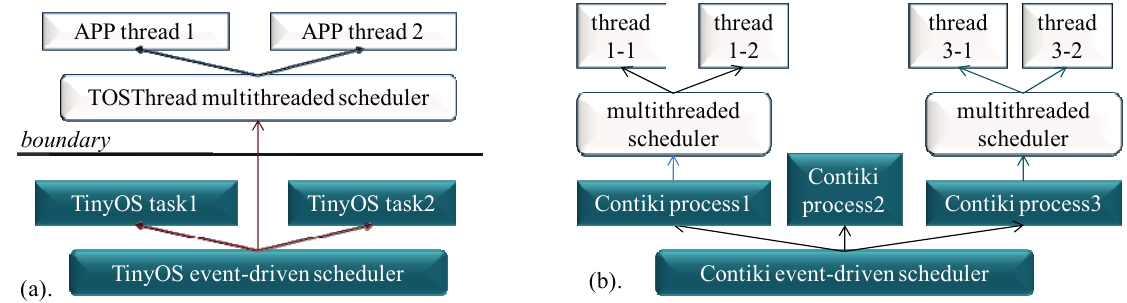
Figure 3. ( a ) Hybrid scheduling structure in the TinyOS TOSThread. ( b ) Hybrid scheduling structure in the Contiki